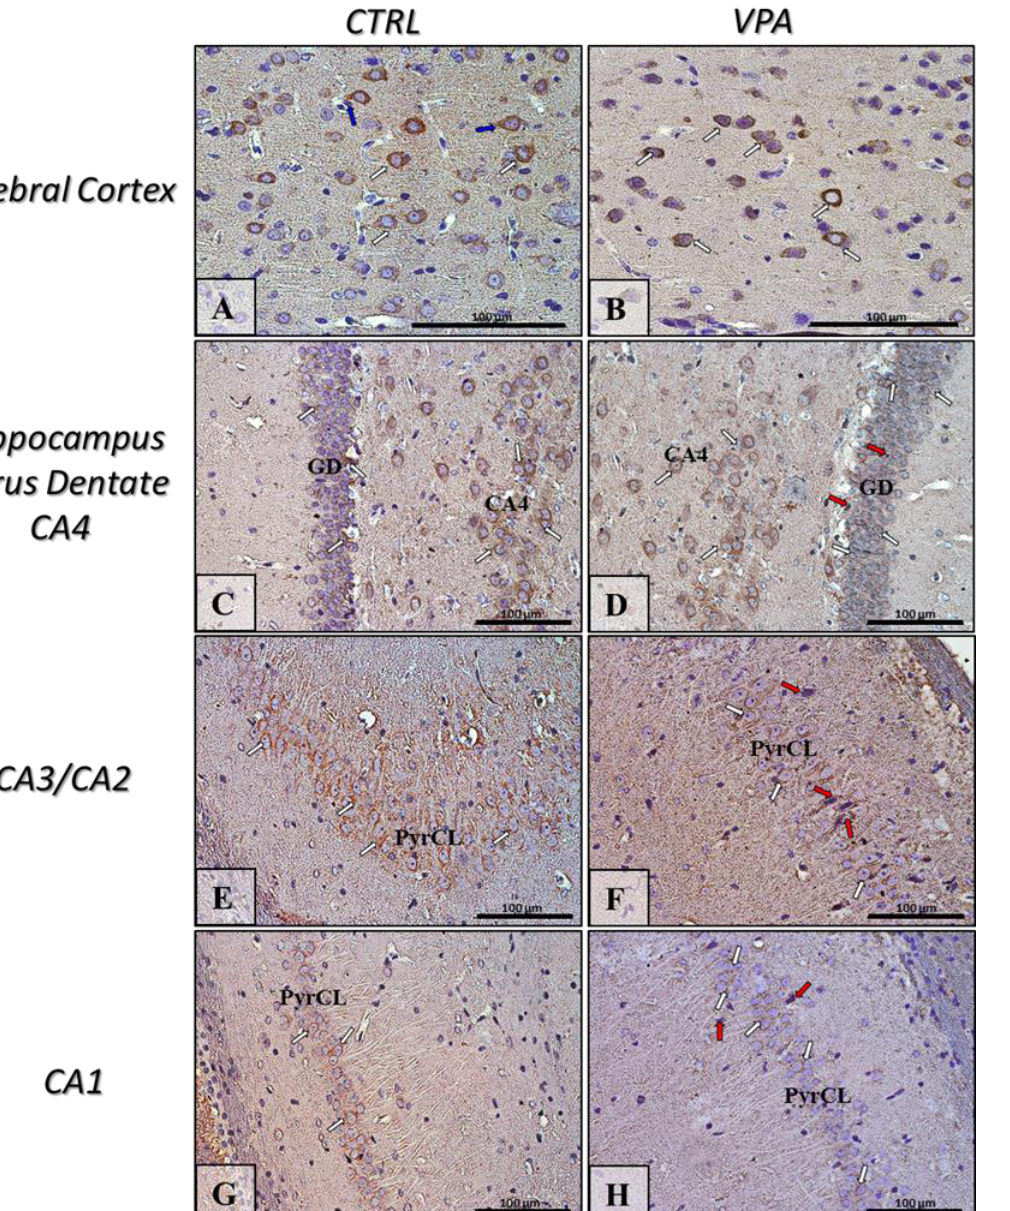
Figure 7. The effect of prenatal exposure to VPA on the immunoreactivity of Tau phosphorylated at (Ser199/202) in the rat brain. Representative microphotography showing immunoexpression of pTau(Ser199/202) in the cerebral cortex and hippocampus proper (GD—Gyrus Dentate, CA1-CA4—the regions of Cornu Ammonis) of control rats ( A , C , E , G ) and VPA- treated rats ( B , D , F , H ). IHC reaction. Scale bar: 100 µm (objective magnification ×40). pTau(Ser199/202)-immunopositive perikaryon (white arrows) and their processes (blue arrows); red arrows—pTau(Ser199/202)-immunonegative or -very low positive neurons with pathologic phenotype (chromatolysis); PyrCL—Pyramidal Cell Layer of CA1-CA3 regions. Representative pictures from n = 11 (CTRL) and n = 9 (VPA) independent experiments in both the hippocampus and cerebral cortex are presented.